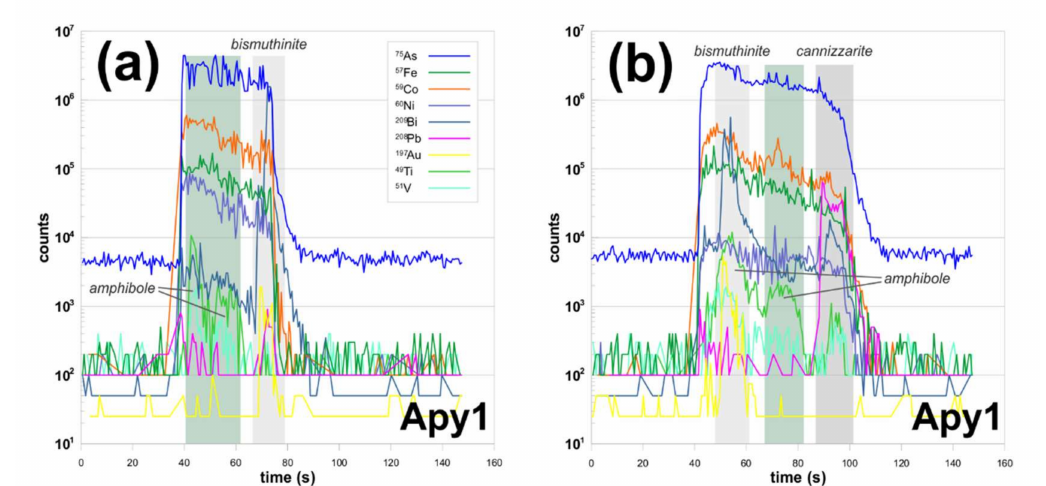
Figure 20. Selected time-resolved laser ablation ICP-MS depth profiles of early arsenopyrite (Apy1) and associated inclusions (highlighted in grey and green) from the Kizhnica hornfels: ( a ) spectra of Apy1; the spiky patterns of Bi and Au could suggest the occurrence of bismuthinite with gold, while Ti and V are related to amphibole inclusions; ( b ) spectra of Apy1; the similarly curved distribution patterns of Bi and Au could be related to inclusions of bismuthinite with gold, while inclusions of cannizzarite could be responsible for similar patterns of Pb and Bi; Ti and V are related to amphibole